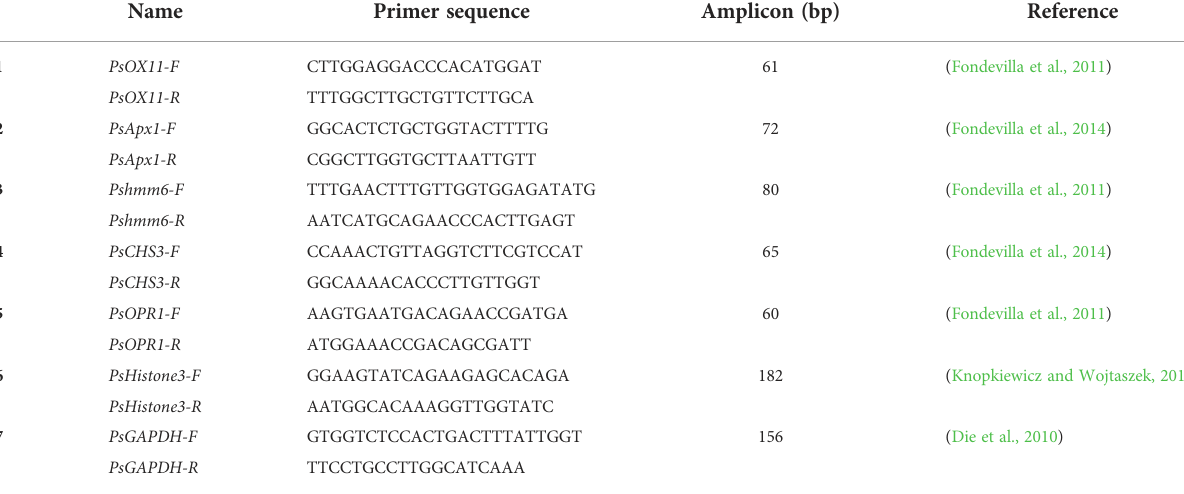
TABLE 3 The RT-qPCR primers of defense related and reference genes used in this